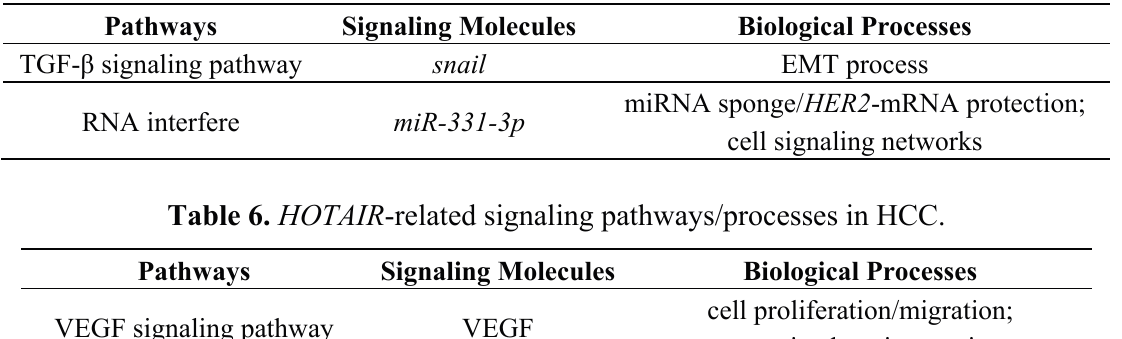
Table 5. HOTAIR -related signaling pathways/processes in GC.